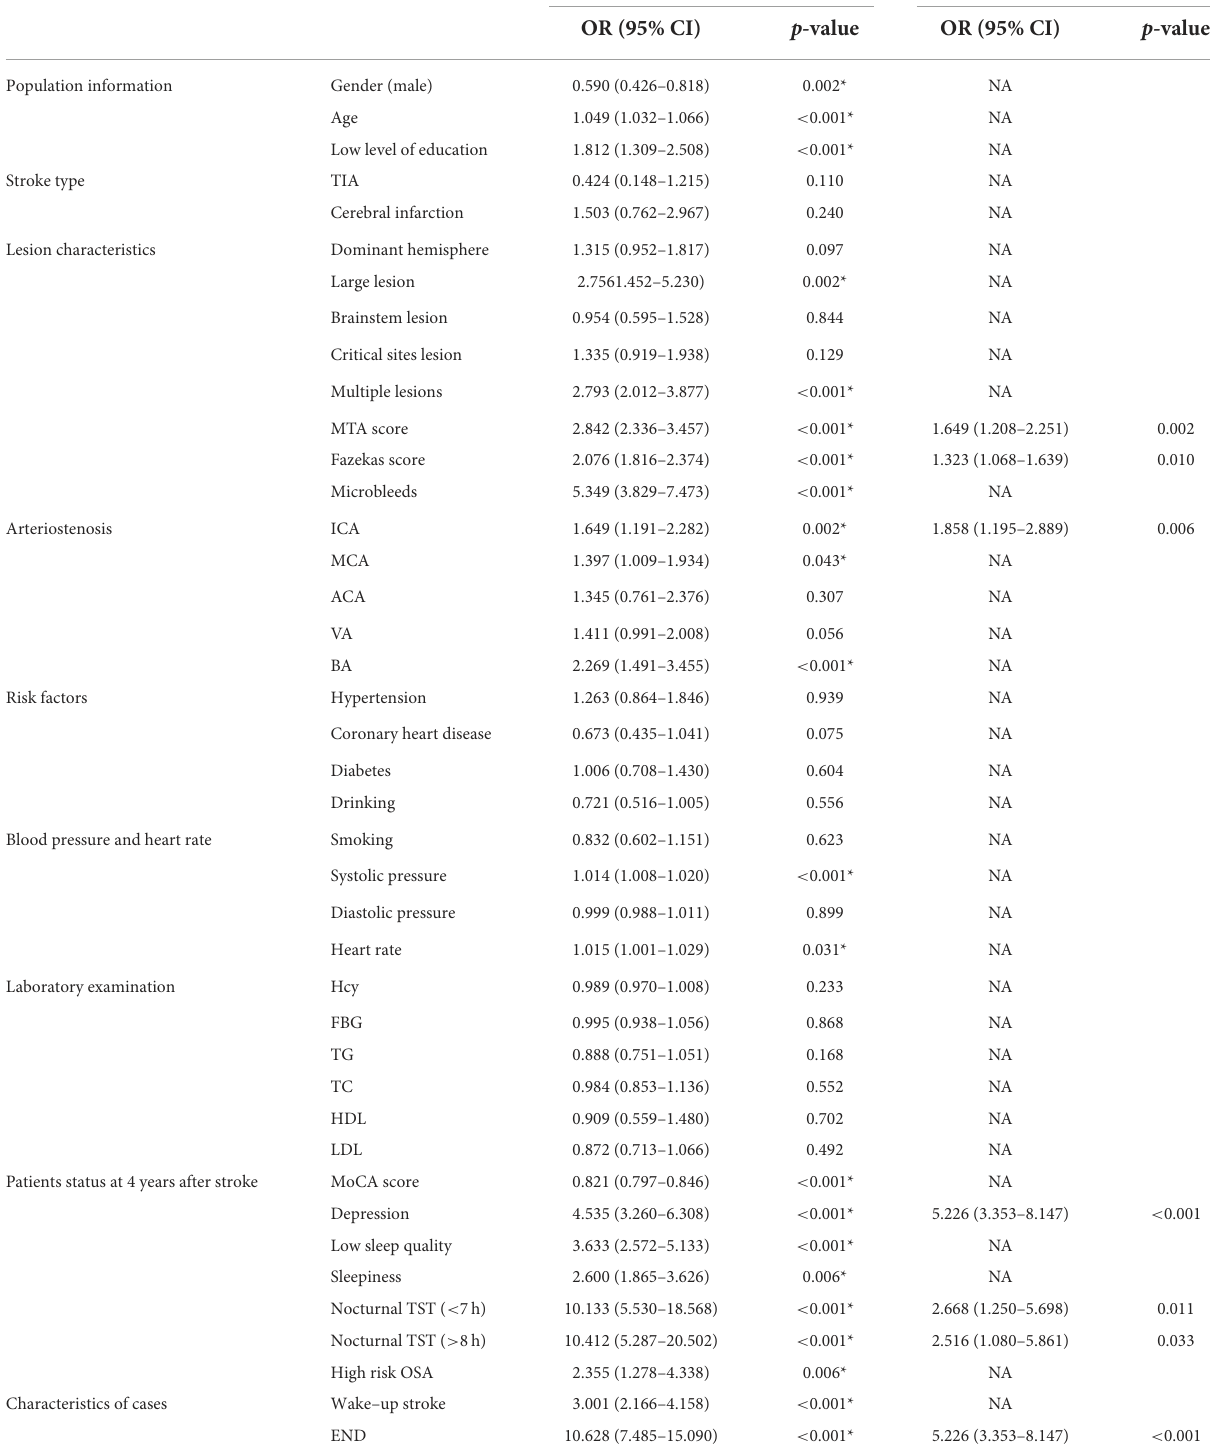
TABLE 4 Univariate and multivariate logistic of neurological function at 4 years after